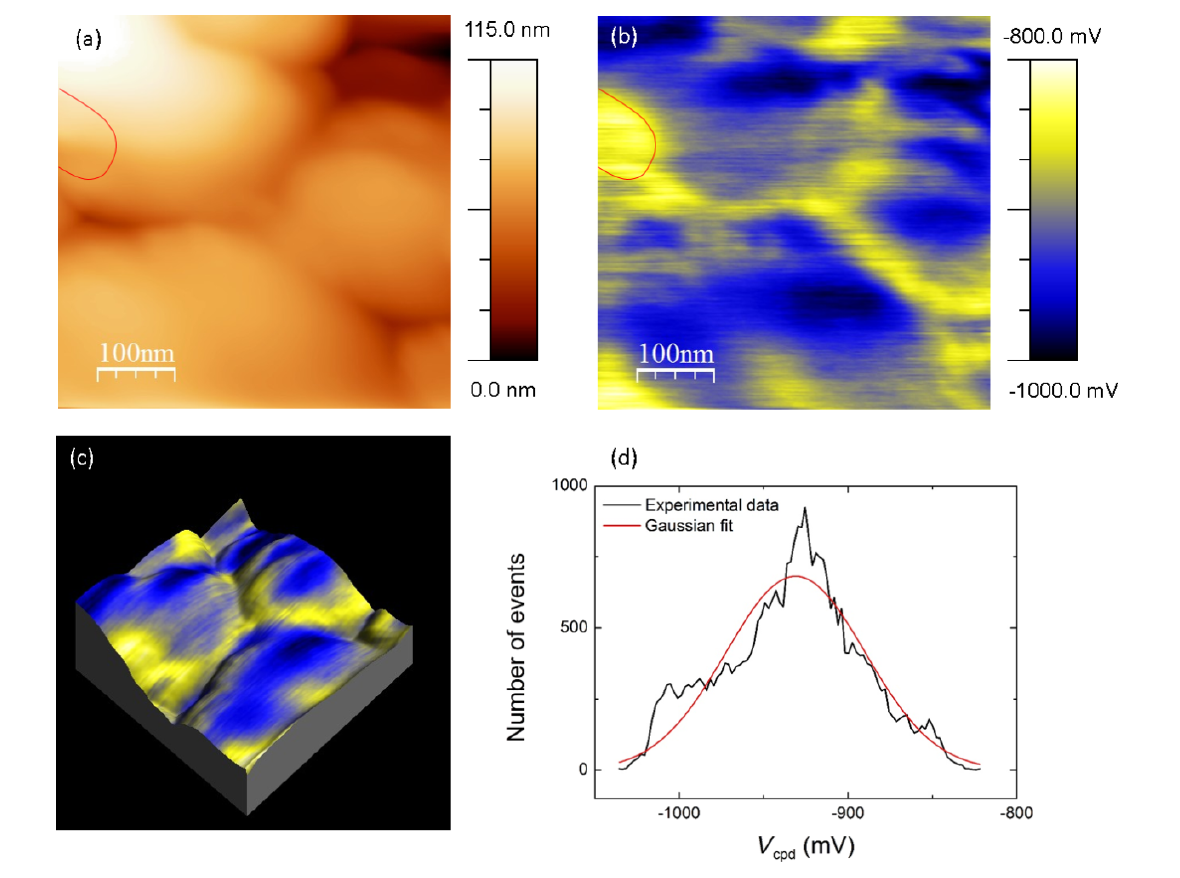
Figure 2: (a) 500 × 500 nm 2 AFM height image of a nanostructured TiO 2 film, obtained in UHV. Height detection parameters: − 22 Hz of frequency shift setpoint and 40 mV of amplitude setpoint. (b) Corresponding KPFM V cpd image. V cpd detection parameters: frequency and amplitude of the elec- trical excitation: 958 Hz and 600 mV. (c) Three-dimensional display of the height image (a), shown with the color scale of the V cpd (b). (d) V cpd histogram extracted from (b) (black line) superimposed with a Gaussian fit (red curve).